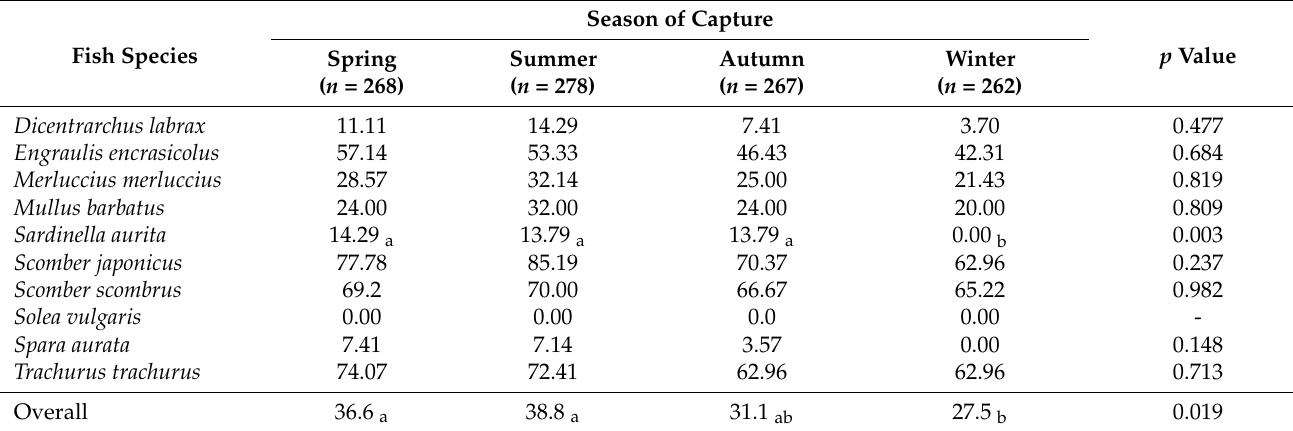
Table 3. Prevalence (%) of anisakid L3 type I larvae in the fish species, analyzed with respect to the season of capture. Values followed by the same letters are not significantly different.